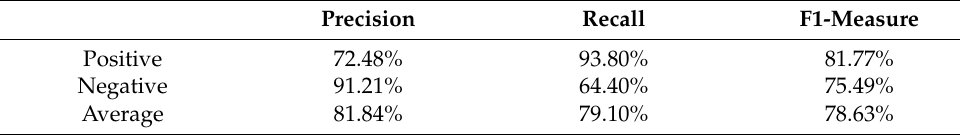
Table 16. Performance evaluation of ontology with level importance